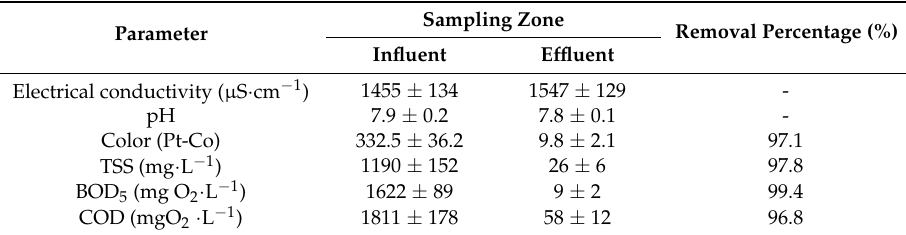
Table 1. Characterization of the influent and effluent from the wastewater treatment plant of the paper mill, and the removal percentages of color, TSS (total suspended solids), BOD 5 (seven-day biochemical oxygen demand) and COD (chemical oxygen demand).